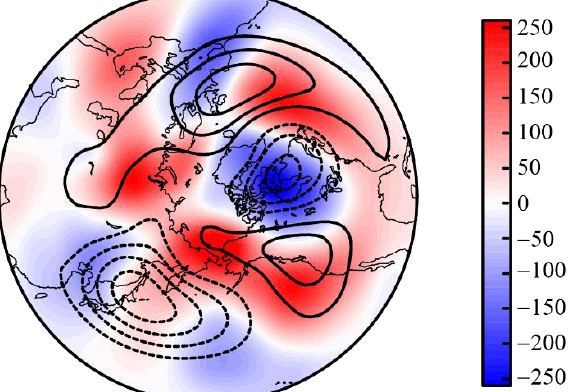
Figure 8. The distribution of geopotential height anomalies at 500 hPa averaged over 10 days (1–10 February) before the SSW onset (shading, unit: gpm). Contours are the zonal deviations of climatological geopotential height in the corresponding period (interval: 50 gpm, zero lines are omitted).